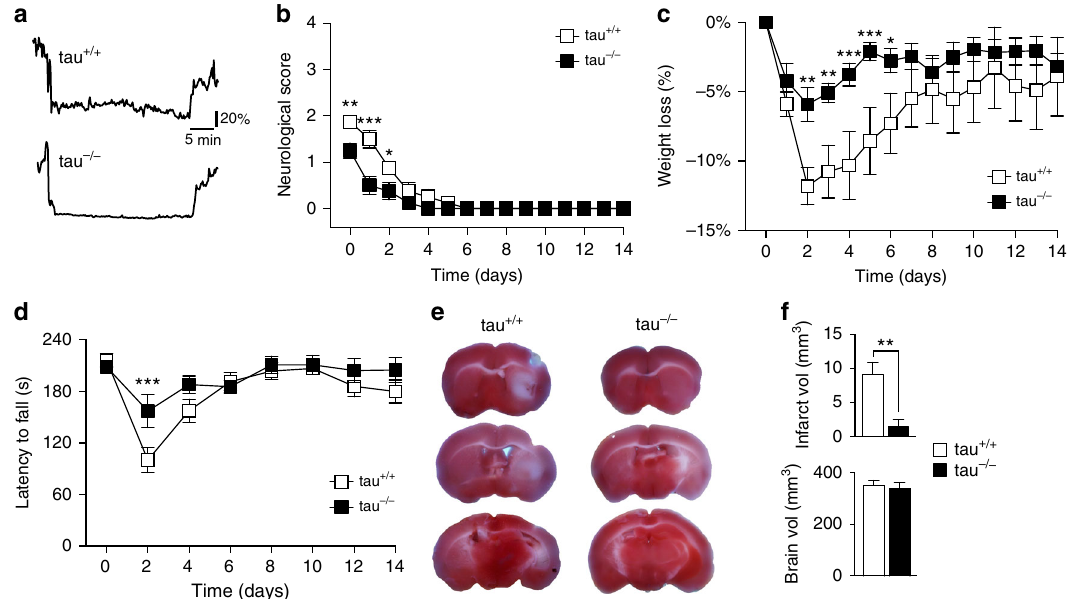
Fig. 3 Accelerated recovery of tau − / − mice from transient MCAO. a For longer-term follow up of tau − / − and tau +/+ mice after stroke, animals were exposed to 30 min of transient MCAO. Representative laser Doppler fl owmetry of the MCAO procedure. Unit, % of baseline fl ow. b Signi fi cantly less neurological de fi cits with faster recovery in tau − / − compared to tau +/+ mice following to 30 min of transient MCAO (* p < 0.05; ** p < 0.01; **** p < 0.0001; N = 8; two-way ANOVA (Sidak post-hoc)). c Signi fi cantly less body weight loss with faster recovery in tau − / − compared to tau +/+ mice following to 30 min of transient MCAO (* p < 0.05; ** p < 0.01; *** p < 0.001; N = 8; two-way ANOVA (Sidak post hoc)). d Tau − / − mice performed signi fi cantly better on the accelerative mode Rota-Rod than tau +/+ animals (*** p < 0.001; N = 8; two-way ANOVA (Sidak post hoc)). e TTC-stained serial brain sections of tau +/+ and tau − / − mice 14 days after 30 min of transient MCAO (viable tissue stains red ). Note the larger infarcted brain area ( white ) in tau +/+ , compared to minimal brain damage in tau − / − mice. f Quanti fi cation of infarct and brains volumes in tau − / − and tau +/+ mice (** P < 0.001; N = 8; Student ’ s t -test). All error bars are